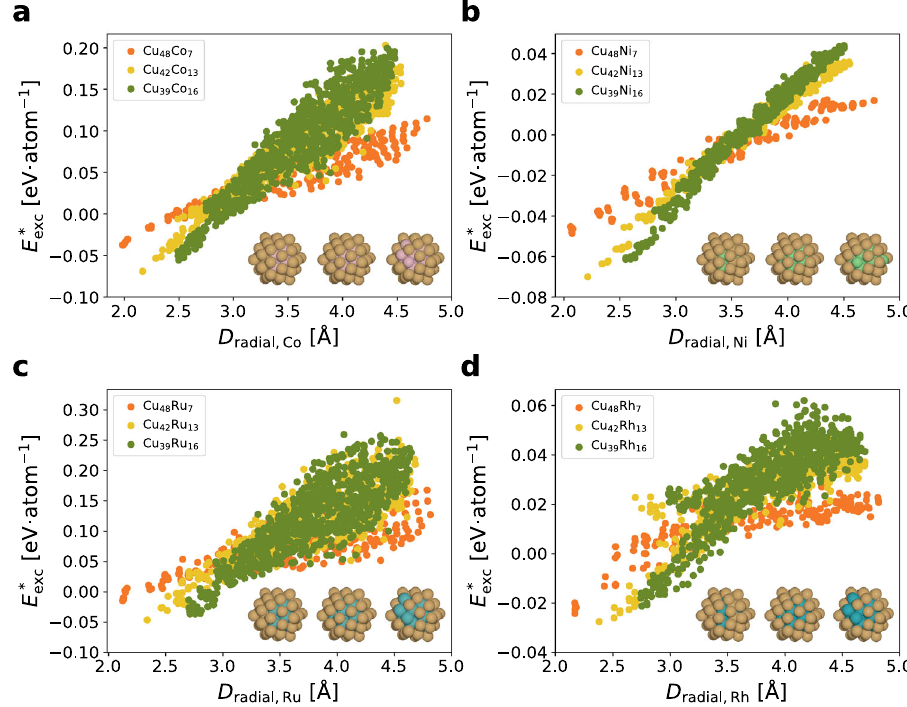
Fig. 2 Energies and structural patterns for alloy clusters. The excess energies ( E (cid:3) = 7, 13, and 16 as a function of the average radial distance ( D n Rh n alloy clusters with n center atom. The insets show the lowest-energy con fi